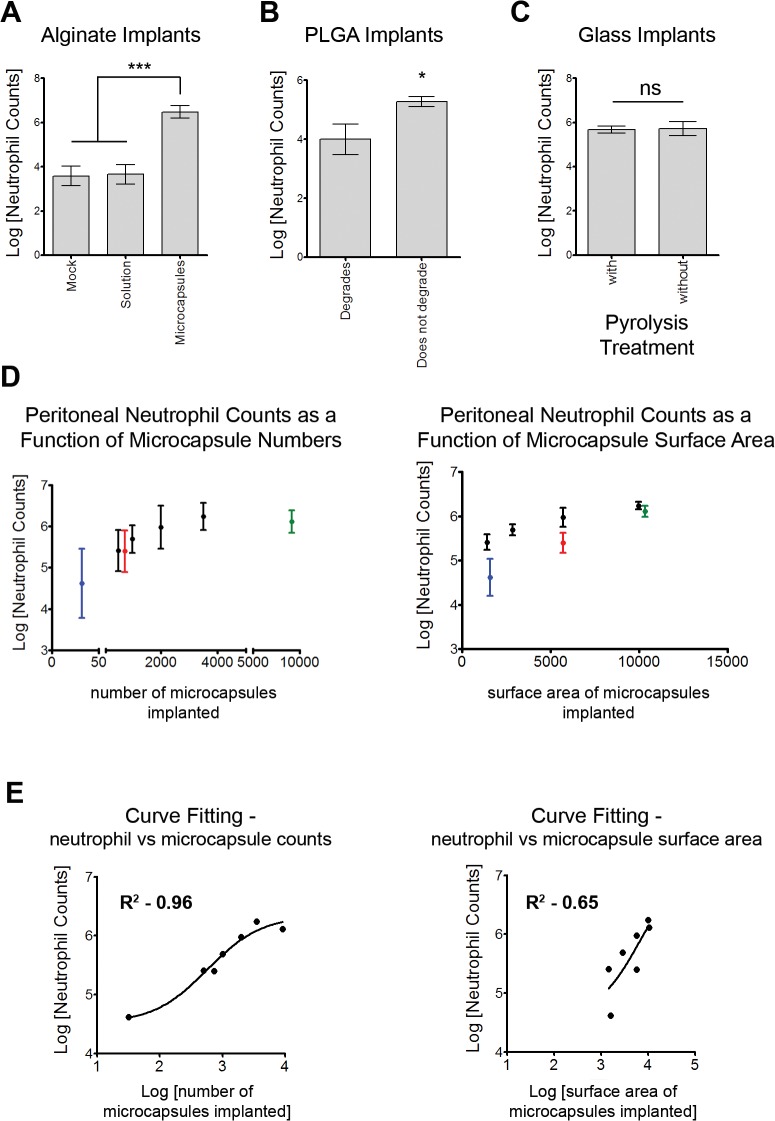
Increased neutrophil presence is due to biomaterial implants.(A)–Comparison of neutrophil counts in mice implanted with alginate in its solution or cross-linked hydrogel microcapsule form (measured 2 weeks following implantation). Mock and alginate microcapsule datasets are the same as presented in Fig 2. (B)–Comparison of neutrophil counts in mice implanted with PLGA that will or will not degrade in 2 weeks (measured 2 weeks following implantation). Datasets on PLGA microcapsules that do not degrade are the same as presented in Fig 2. Data are based on at least 2 independent experiments with n ≥ 5 for A and B. *** indicates p<0.001, using one-way ANOVA followed by Bonferroni post-test. (C)–Comparison of neutrophil counts in mice implanted with glass microcapsules that did or did not undergo pyrolysis treatment. Data are based on at least 1 independent experiment with n ≥ 4. 'ns' indicates not significant. Datasets on glass microcapsules that were not pyrolysis treated are the same as presented in Fig 2. (D)–Dependence of number of neutrophils observed in the peritoneal exduate on the number of microcapsules implanted, and less to absence of dependence on surface area of microcapsules. Black dots represent ~500μm, green dot represents ~300μm, red dot represents ~800μm and blue dot represents ~2000μm alginate microcapsules. Data are based on at least 1 independent experiment with n ≥ 5 mice for each microcapsule count. (E)–Curve fitting for data presented in 'D'. A non-linear 3-parameter dose response curve (mean of Log[neutrophil counts] vs Log[microcapsule count] or Log[microcapsule surface area]) was fitted assuming that microcapsules act as a stimulant for neutrophils. R2 value was 0.96 for the fit using the microcapsule counts, suggesting a direct correlation between neutrophil counts and microcapsule counts.